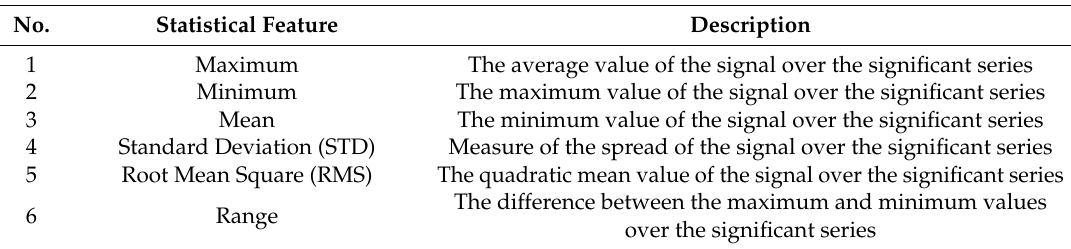
Table 2. Statistical features calculation and description.